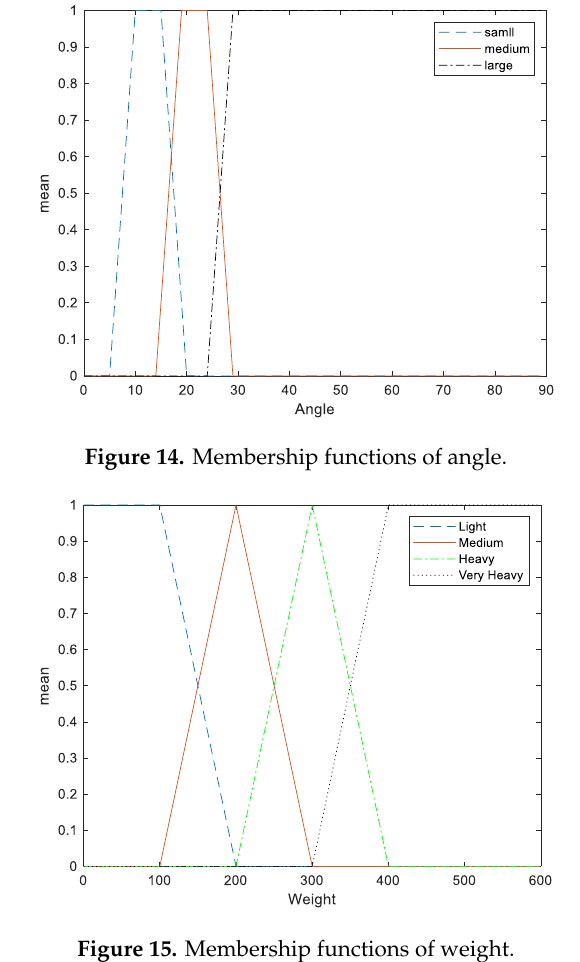
Figure 15. Membership functions of weight.